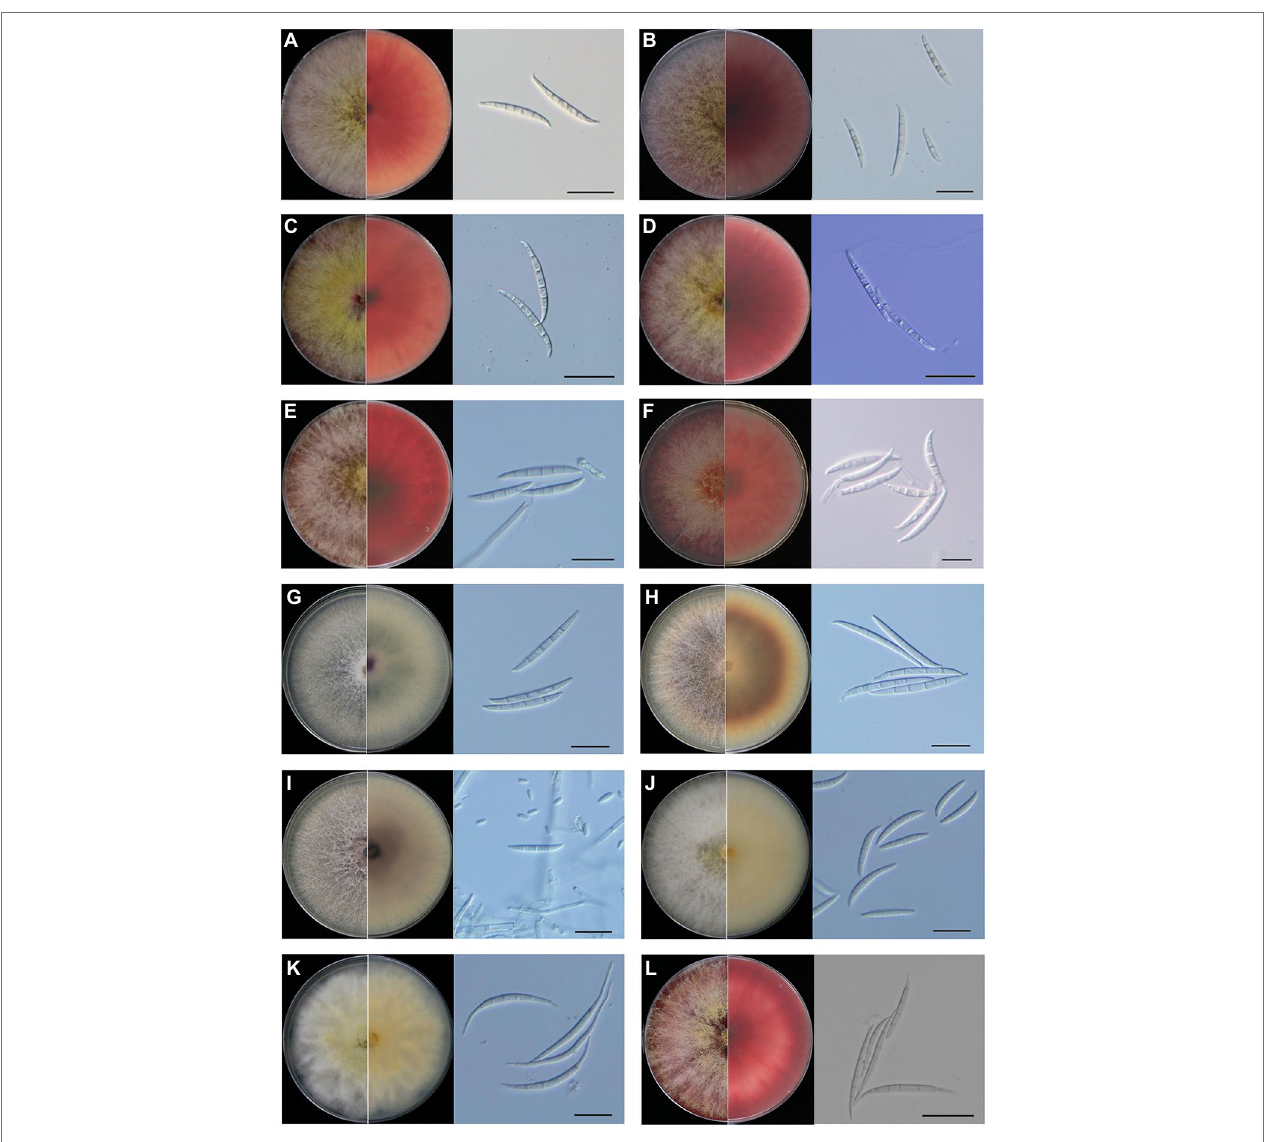
FIGURE 2 | Morphological characteristics of Fusarium species isolated from maize stalk rot disease in Yunnan Province, China. Typical colonies of the representative Fusarium isolates were observed on potato dextrose agar (PDA) plates at 5 days post-inoculation (dpi). Microscopic features of macroconidia of each Fusarium species. (A) Fusarium graminearum , (B) Fusarium meridionale , (C) Fusarium boothii , (D) Fusarium asiaticum , (E) Fusarium cortaderiae , (F) Fusarium cerealis , (G) Fusarium proliferatum , (H) Fusarium temperatum , (I) Fusarium verticillioides , (J) Fusarium incarnatum , (K) Fusarium equiseti , and (L) Fusarium avenaceum . Scale bar = 20 μ